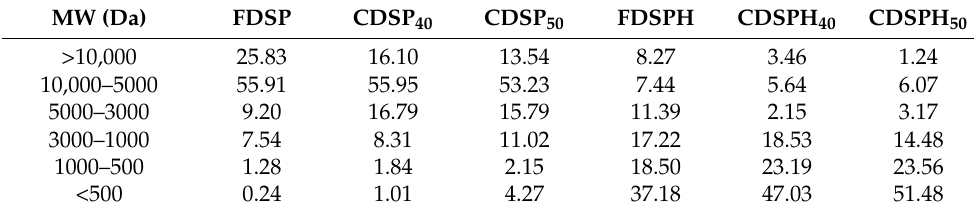
Table 3. M weight (%) of freeze- and convectively-dried SP and SPH. MW (Da)